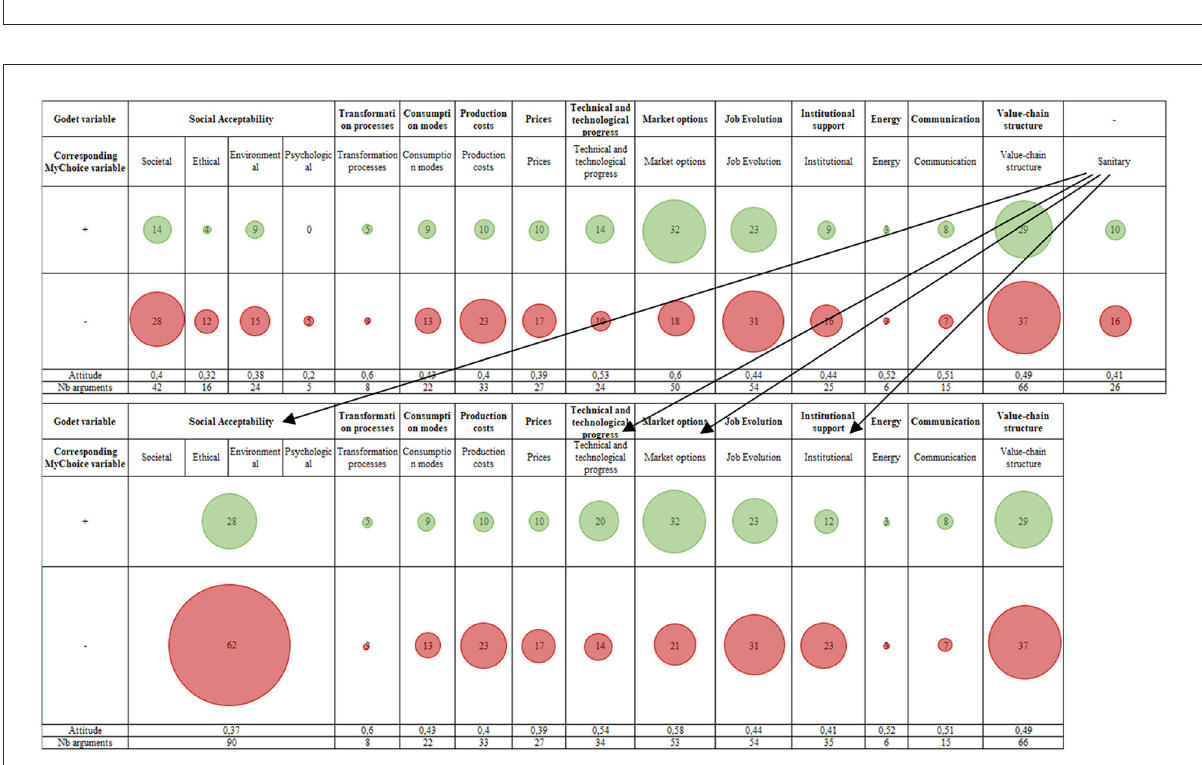
FIGURE4 Identified variables in the adapted Godet method and the MyChoice tool. The top block details the quantities of positive and negative evaluations of the variables in the MyChoice tool. The bottom block details them for the adapted Godet method. Together with the explanations provided by the interviews, these evaluations are called “arguments”, counted in the last row of each block. The arrows express that information associated with the “Sanitary” variable in the MyChoice tool are dispatched in several variables (Social Acceptability, etc.) in the Godet